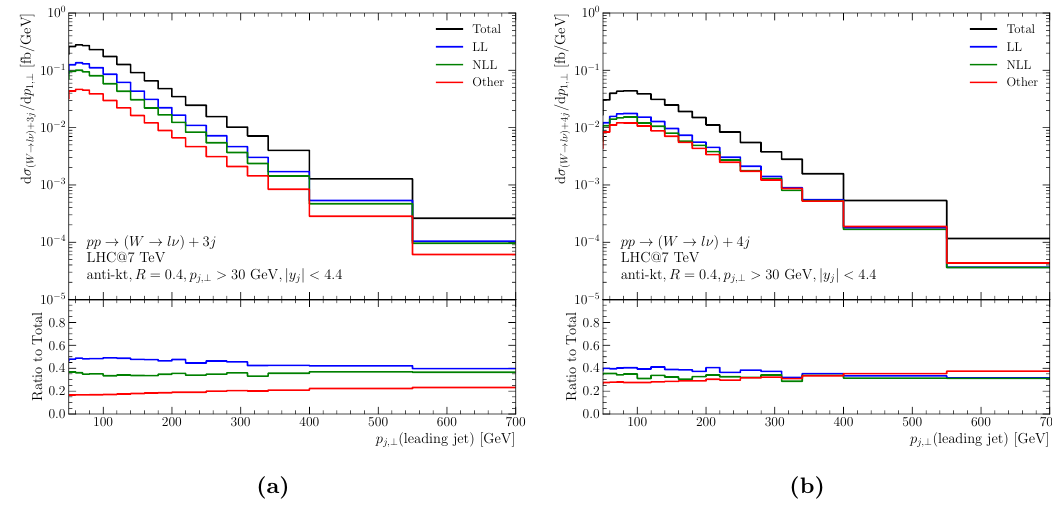
Figure 4. The leading order (a) W + 3 -jet and (b) W + 4 -jet cross sections as a function of the transverse momentum of the hardest jet, p . In addition to the total (black), we also show the ⊥ , 1 split into the contributions from the LL configurations (blue), NLL configurations (green) and other configurations (red). As p increases, the LL configurations decrease in importance underlining ⊥ , 1 the importance of also applying resummation to the NLL